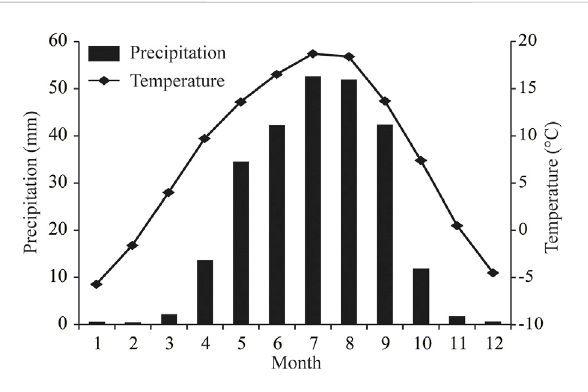
FIGURE 2 Monthly averaged temperature and precipitation data for